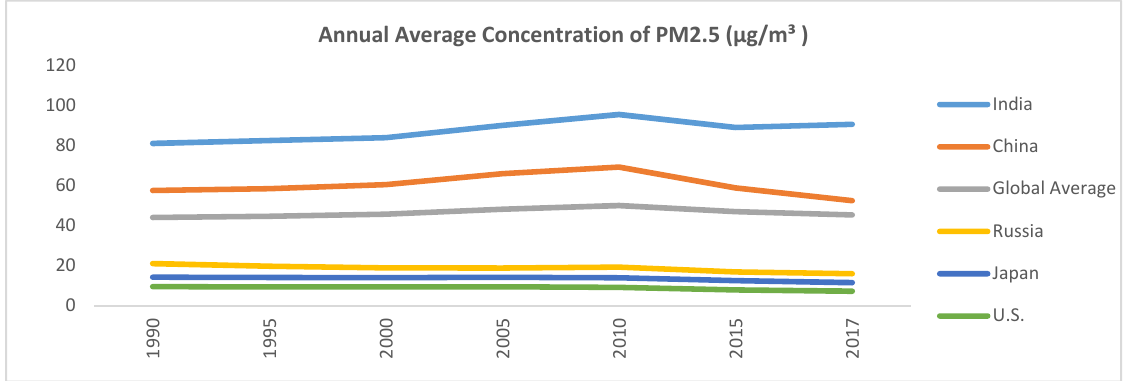
Figure 4. Comparison of annual average contraction of PM2.5 in major countries. Source: data compiled from World Bank, 2021.